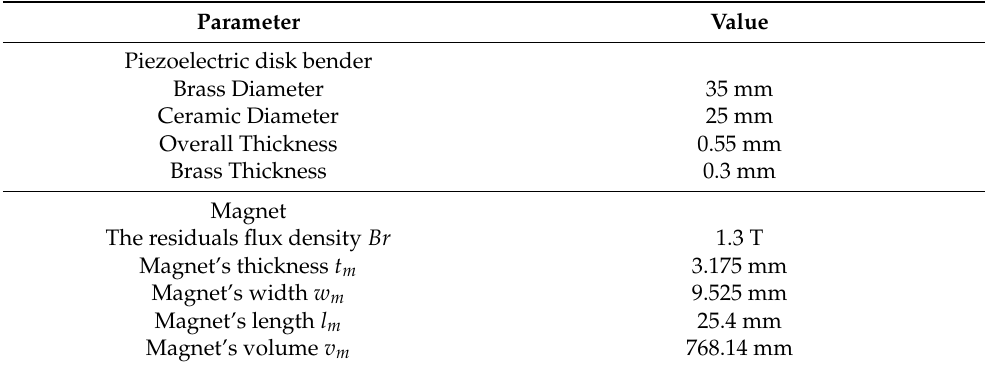
Table 2. The prototype’s dimensions and